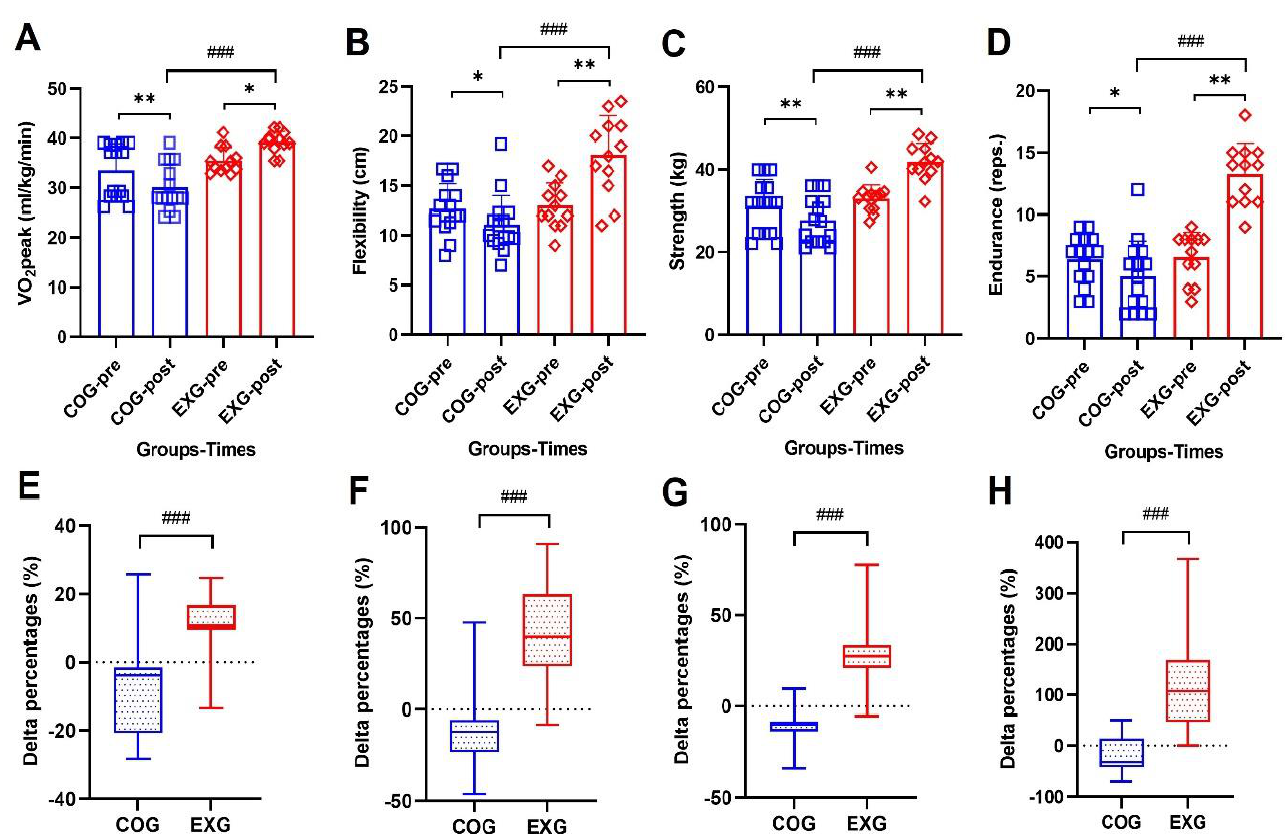
Figure 3. Aerobic exercise + resistance exercise for 6 days a week of 12 weeks improves the physical fitness of survivors after ovarian cancer resection. ( A ) Peak oxygen consumption (VO 2 peak) in the control group (COG) and in the exercise group (EXG). ( B ) Flexibility in the COG and EXG. ( C ) Strength in the COG and EXG. ( D ) Muscle endurance in the COG and EXG. ( E ) Percentages of VO 2 peak analyzed as ∆ % in both groups. ( F ) Percentages of flexibility analyzed as ∆ % in both groups. ( G ) Percentages of strength analyzed as ∆ % in both groups. ( H ) Percentages of muscle endurance analyzed as ∆ % in both groups. All data are represented as means ± SD. p -values were calculated by Student’s t test or Mann–Whitney U test. For ( A ) to ( H ), these tests were performed independently at each time point; ### p < 0.001. p -values were calculated by Student’s t test or Wilcoxon signed rank test. For ( A ) to ( D ), these tests were performed dependently at each time point; * p < 0.05 and ** p <